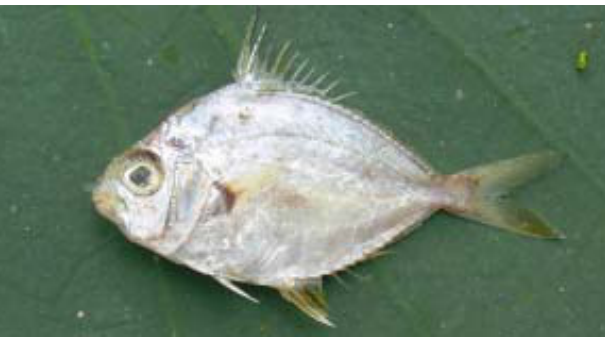
Image 28. Splendid Ponyfish Leiognathus splendens